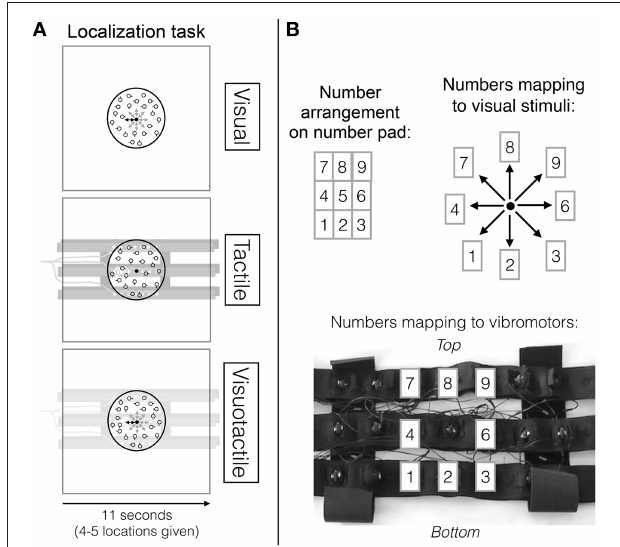
FIGURE 1 | (A) Localization task overview. The top row depicts the visual localization task (in which visual location cues were received), the middle row the tactile localization task (in which tactile location cues were received) and the bottom row the visuotactile localization task (in which visual and tactile location cues that point to the same direction were received). (B) Mapping of number pad (top left) to visual spatial cues on the screen (top right) and to tactile spatial cues (bottom). This figure has been adapted from our previous study (Wahn and König, 2015b) with permission of Koninklijke Brill